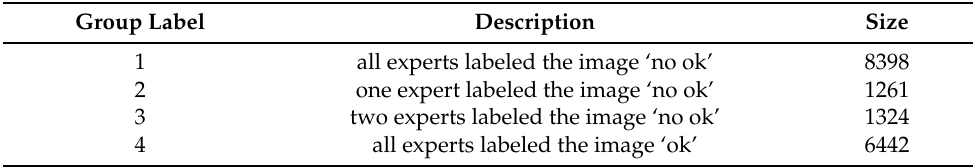
Table 1. The size of individual groups. Group